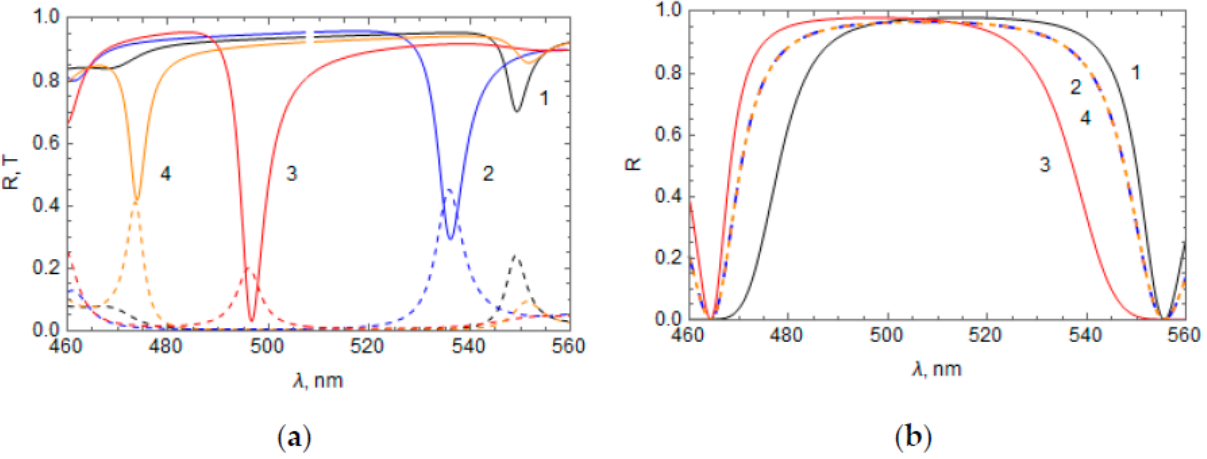
Figure 2. ( a ) Reflectance and transmittance spectra of the “Ag layer–RF” system at different initial phase α : α = − π /2 (1, black), 0 (2, blue), π /2 (3, red), and π (4, orange); reflectance—Solid lines, transmittance—Dashed lines, Ag film thickness = 45 nm. ( b ) Reflectance spectrum of only the RF, where the numbers near the curves correspond with the α values used in Figure